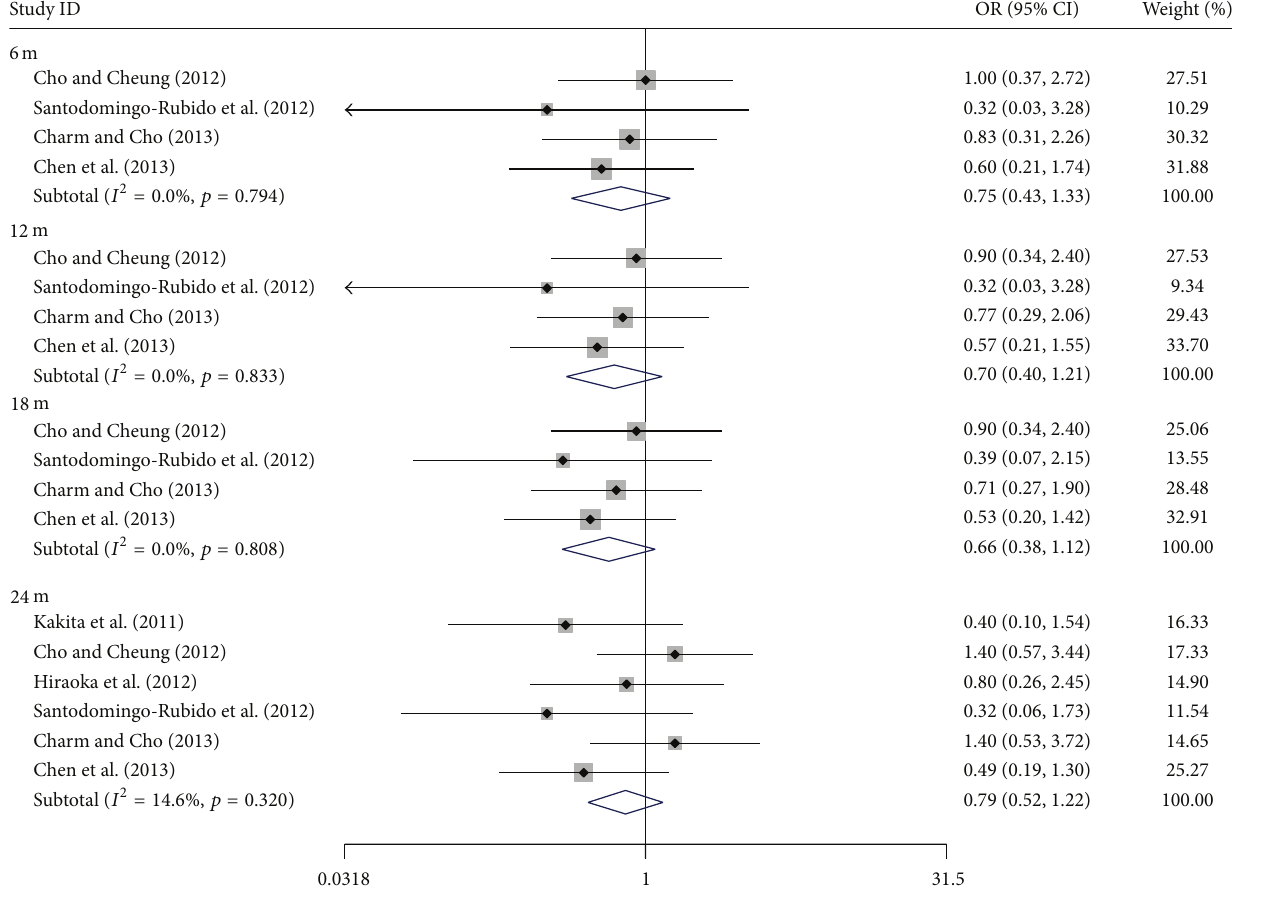
Figure 5: Odds ratios (OR) of dropout rates between orthokeratology and controls with different treatment durations.